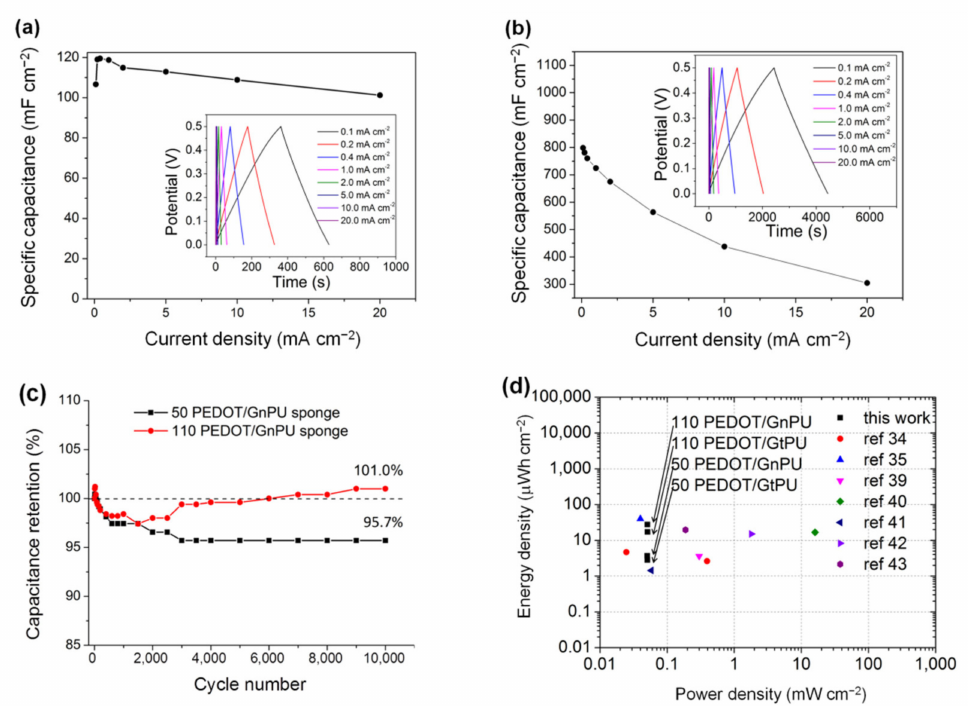
Figure 8. Specific capacitance values of the symmetric supercapacitor cells assembled with 50 PE- DOT/GnPU sponge ( a ) and 110 PEDOT/GnPU sponge ( b ) measured with different scan rates from 0.1 to 20 mA cm − 2 . The insets show the CD curves under each scan rate. ( c ) Specific capacitance reten- tion versus cycle number for the symmetric supercapacitor cells assembled with 50 PEDOT/GnPU or 110 PEDOT/GnPU composite sponge. The CD tests were measured with the scan rate of 20 mA cm − 2 . ( d ) Areal-normalized Ragone plot showing the comparison with cited